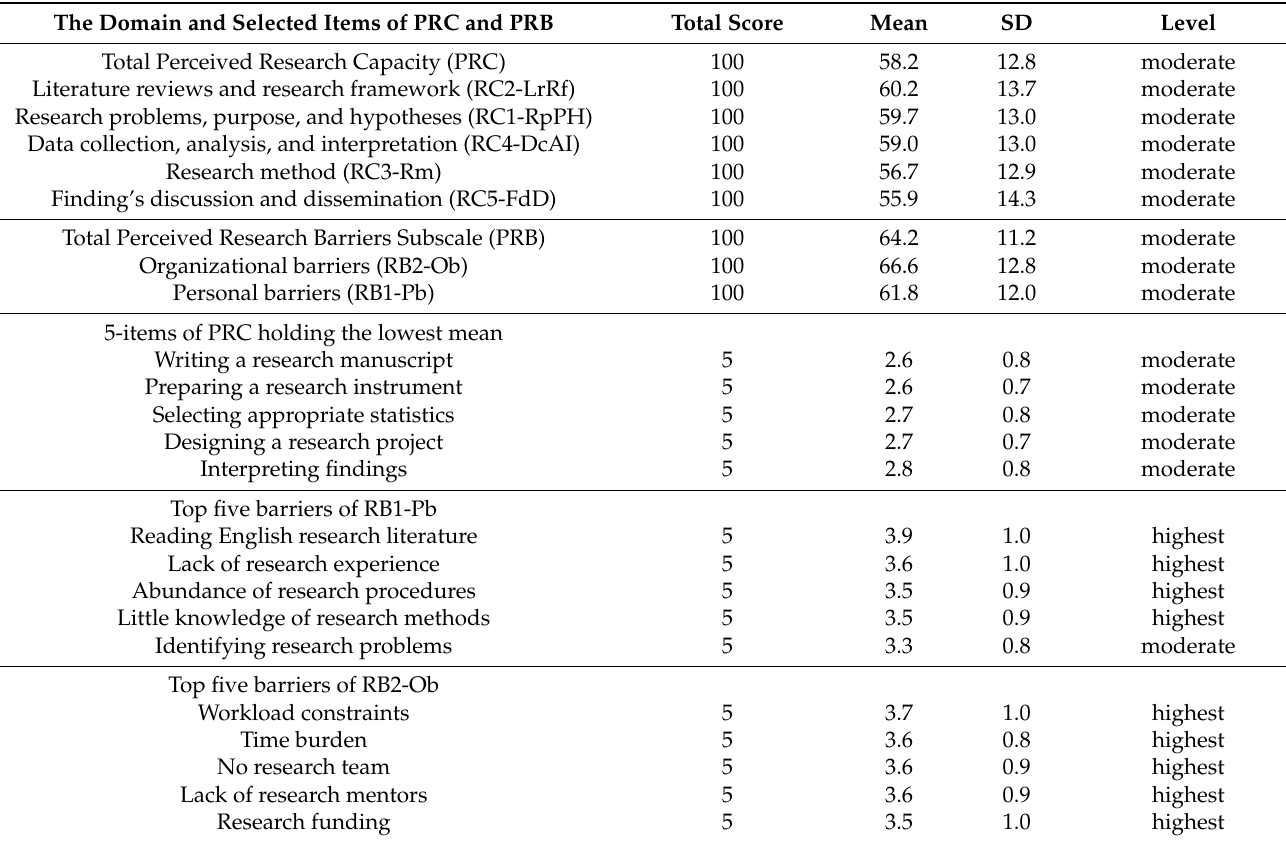
Table 2. Perceived Research Capacity (PRC) and Perceived Research Barriers